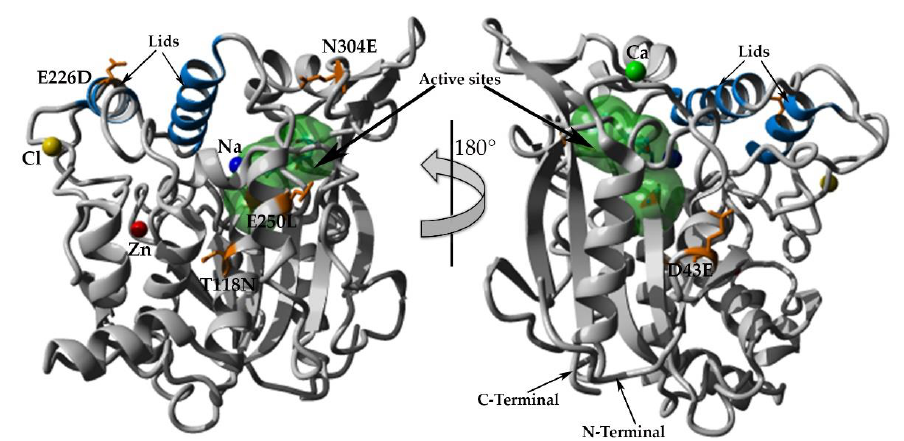
Figure 6. Overall structure of HT1 lipase with mutated amino acids. The figure was generated by YASARA software [20]. Blue color helical structures represent the lids. Amino acids covered with green surface represent active sites. Mutated amino acids colored in brown. Green ball represents calcium ion, yellow ball represents chloride ion, blue ball represents sodium ion, and red ball represents zinc ion.